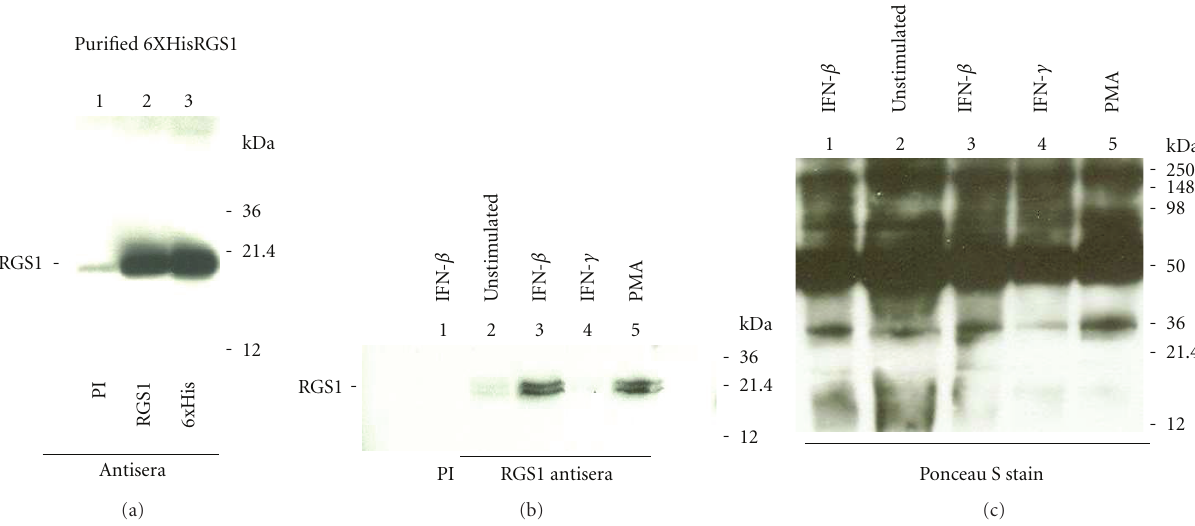
Figure 6: Immunoprecipation of RGS1 from human PBMCs . Purified 6xHisRGS1 was used to evaluate RGS1 immune sera (a). 6xHisRGS1 was subjected to SDS-PAGE followed by immunoblotting as described in Section 2. The resultant immunoblot was probed with either preimmune sera (PI), RGS1 immune sera, or a specific antibody recognizing 6xHis. Lane 1, preimmune sera (PI); lane 2 RGS1 antisera (RGS1); lane 3 6xHis antisera (6xHis). (b) PBMCs were stimulated for 20 hours with either IFN- β (1000IU/mL); IFN- γ (1000IU/mL), or PMA (2ng/mL).RGS1 wasimmunoprecipated using cell lysates obtained from equal amountsof cells (2 × 10 8 cells/sample) and a normalized protein concentration. Immunoprecipated RGS1 was detected by immunoblotting using RGS1-specific antisera as described in Section 2. Lane 1, preimmune sera IFN- β -stimulated; lane 2, RGS1 antisera (unstimulated cells); lane 3, RGS1 antisera (IFN- β -stimulated cells); lane 4, RGS1 antisera (IFN- γ -stimulated cells); lane 5, RGS1 antisera (PMA-stimulated cells). The location of RGS1 (23kDa) is indicated (RGS1). (c) Ponceau S staining of the PVDF membrane to visualize e ffi ciency of protein transfer and load. Molecular weight markers are alsoincluded